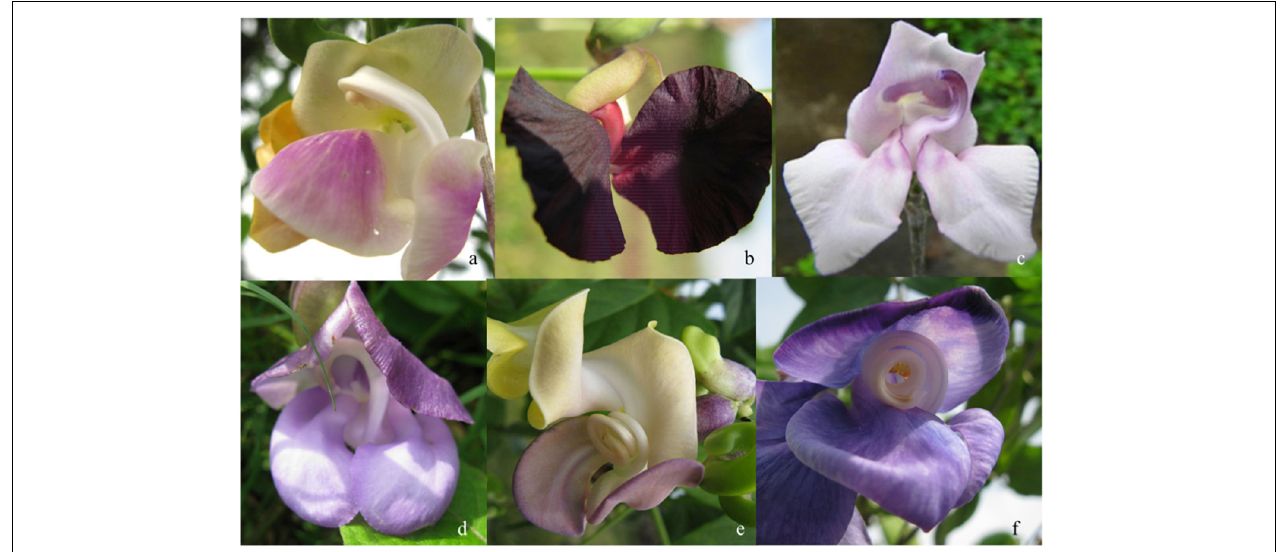
FIGURE 2 | (a) Leptospron adenanthum (G. Meyer) A. Delgado. (b) Macroptilium atropurpureum (DC.) Urban. (c) Ancistrotropis peduncularis (Fawcett & Rendle) A. Delgado. (d) Sigmoidotropis speciosa (Kunth) A. Delgado. (e) Cochliasanthus caracalla (L.) Trew. (f) Helicotropis linearis (Kunth) A. Delgado (photographs taken by D.G. Debouck except e by A. Ciprián).